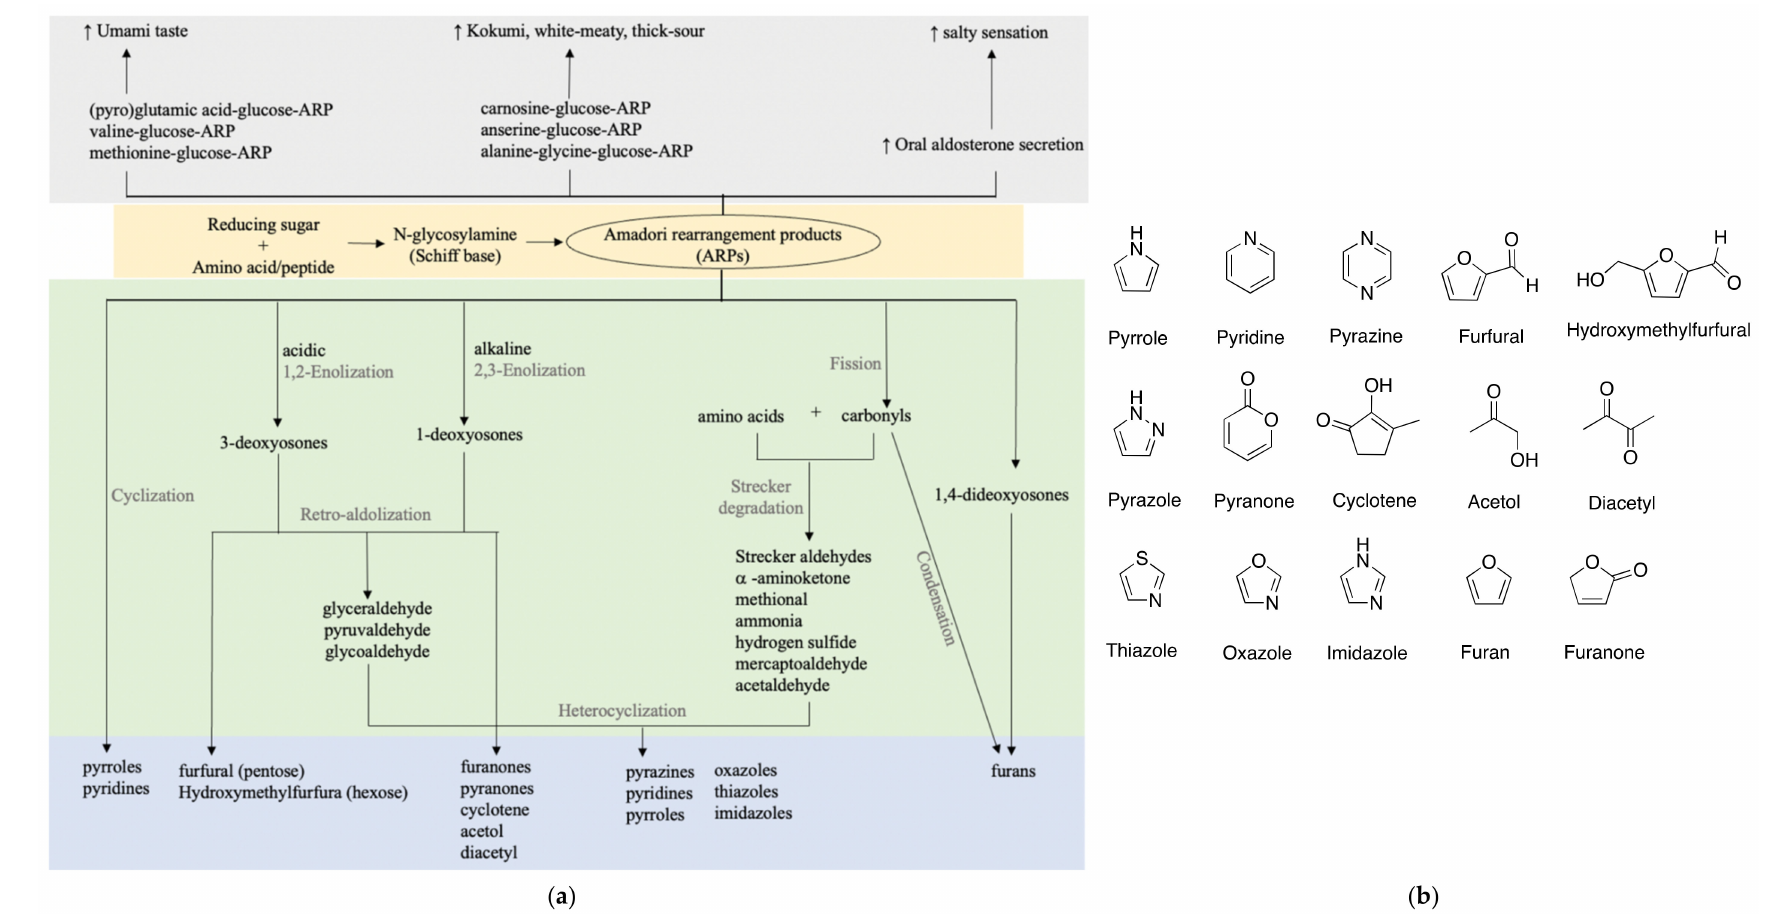
Figure 2. Taste and flavor formation of ARPs. ( a ) Taste enhancing properties and flavor formation of ARPs; ( b ) basic chemical structures of key